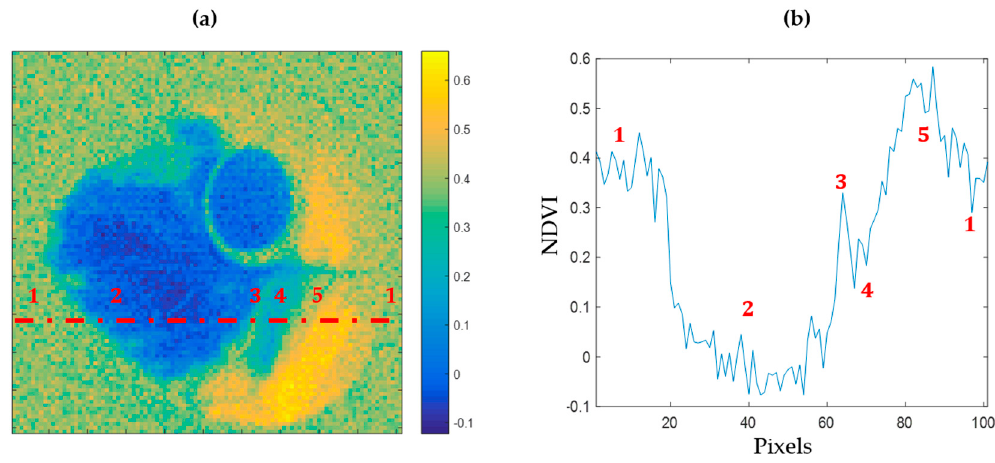
Figure 5. Detection of different health states within a hydrangea leaf. ( a ) NDVI mapping of the reconstructed image. ( b ) Analysis of different health states from the red dotted line of NDVI map.